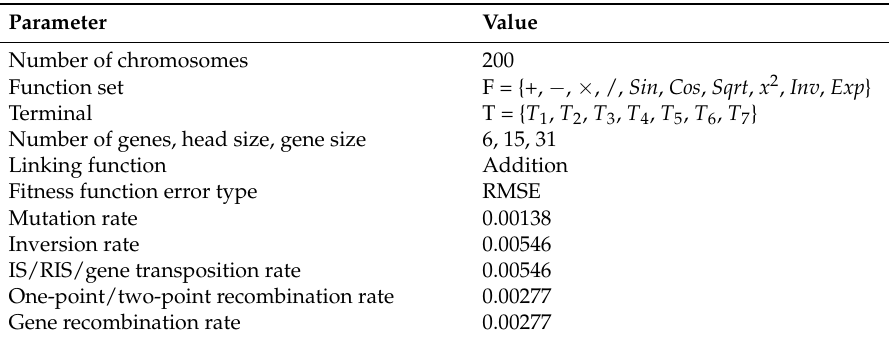
Table 1. Parameters for the GEP algorithm in the training stage.